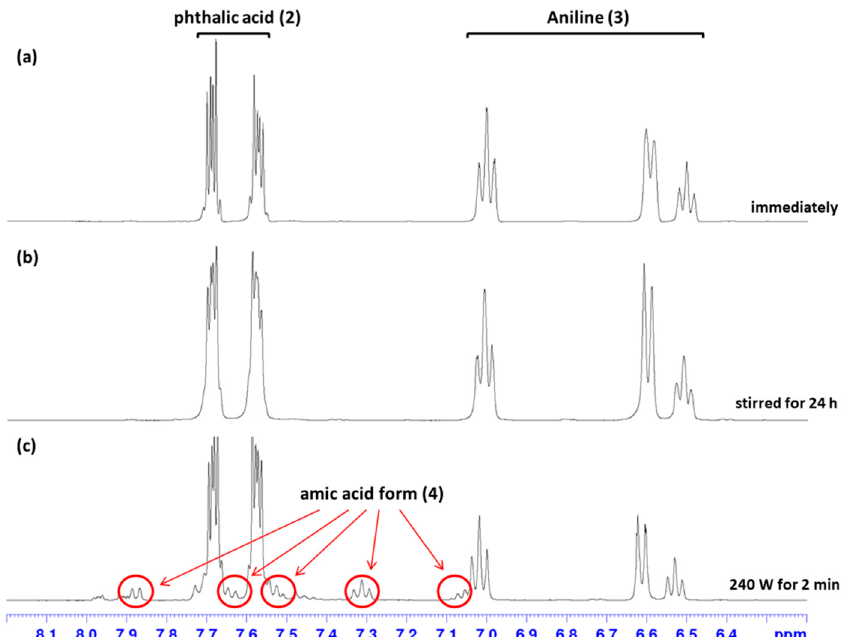
Figure 4. Acquired 1 H NMR spectra of reaction mixtures of 2 and 3 in NMP ( a ) immediately after the two compounds were homogeneously mixed, ( b ) after the mixture was stirred for 24 h at room temperature, and ( c ) after the mixture was subjected to MW irradiation at 240 W for 2 min.